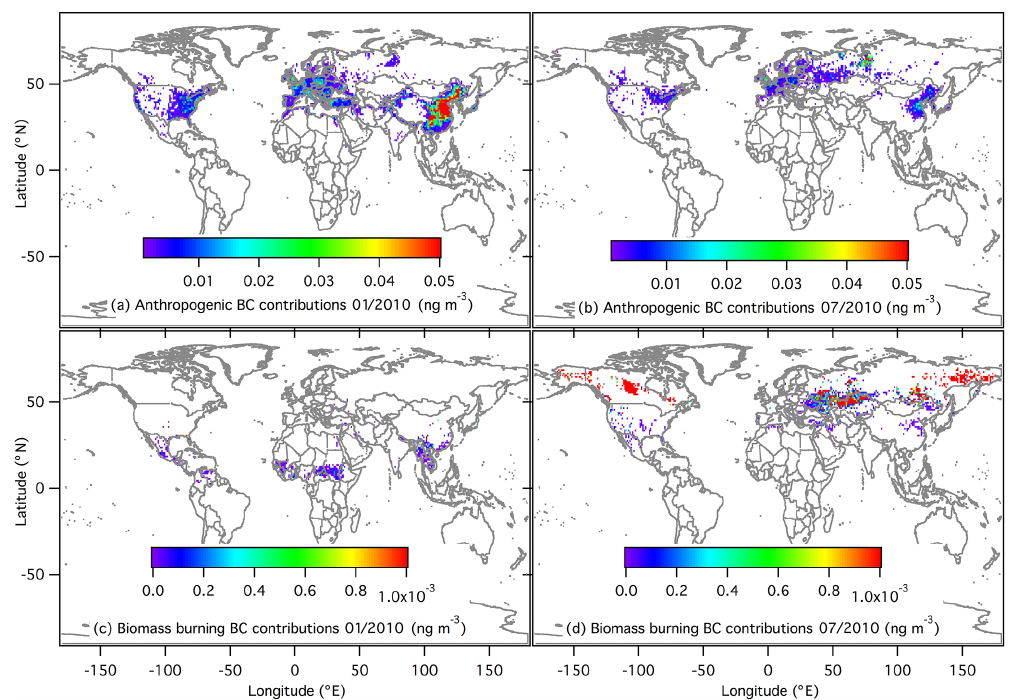
Figure 7. Spatial distributions of contributions to Arctic BC at high altitudes for (a) anthropogenic contributions in January 2010, (b) an- thropogenic contributions in July 2010, (c) open biomass burning contributions in January 2010, and (d) open biomass burning contributions in July